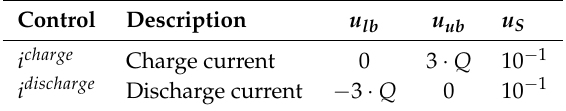
Table 5. Control upper and lower bounds as well as scalings.